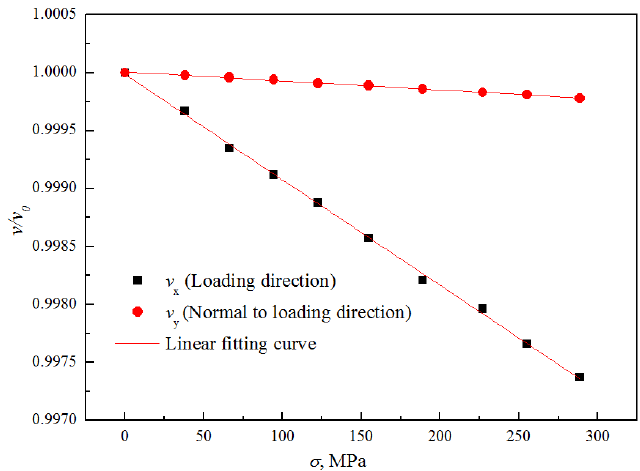
Figure 4. The relationship between velocity ratio and tensile stress. The slopes of the linear fitting curve correspond to the acoustoelastic coefficients.